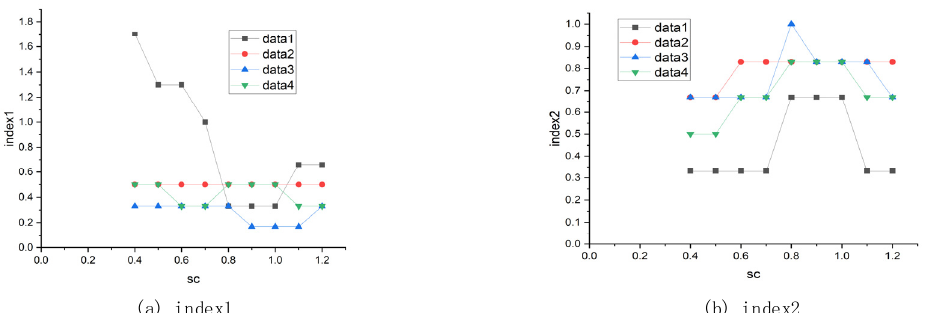
Figure 12. The effect of elasticity coefficient on the results.